Question: Provide a publication-style caption for this figure.
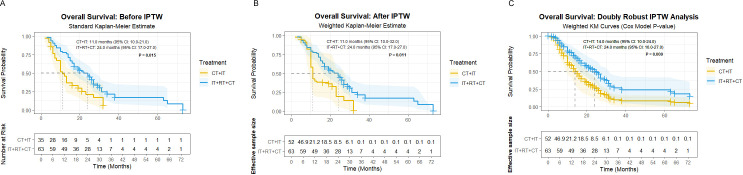
Answer: OS of the IT+RT+CT Group and CT+IT Group in the First-line and Subsequent-line Treatments. (A) Kaplan-Meier analysis before IPTW. (B) conventional IPTW Kaplan-Meier analysis after IPTW. (C) Adjusted Kaplan-Meier survival curves generated via the IPTW-ATT doubly robust framework. The number-at-risk table below the curves displays raw patient counts for the IT+RT+CT Group (due to the fixed weight of 1 in the ATT design) and weighted effective sample sizes for the CT+IT Group.